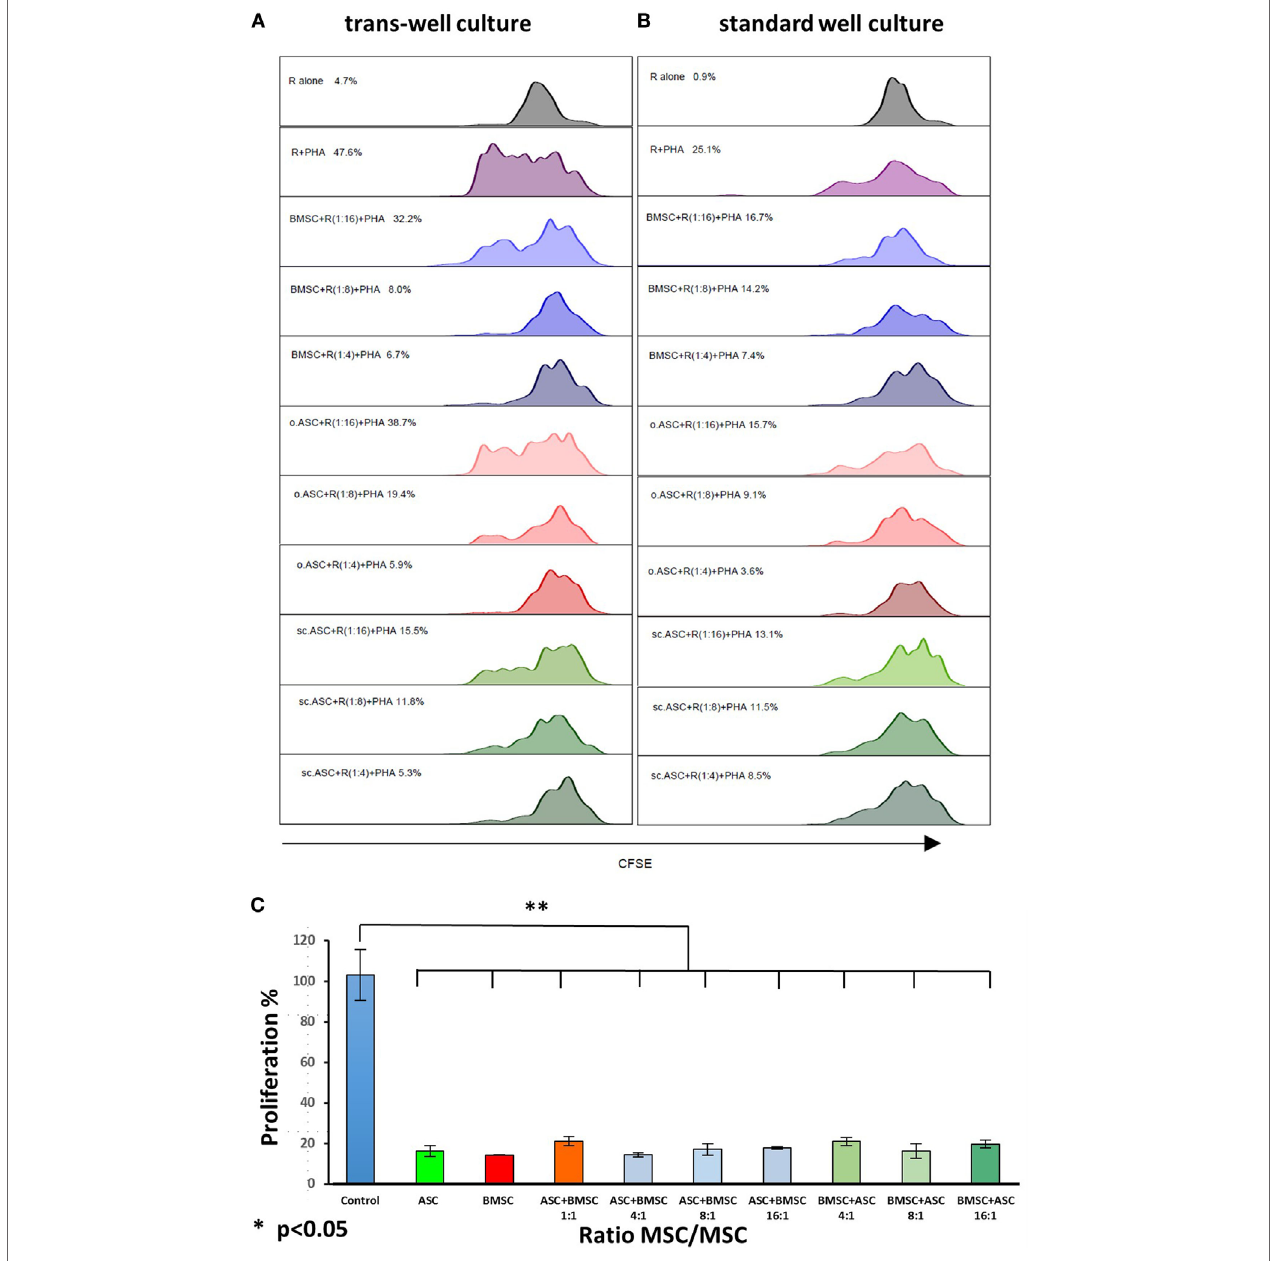
FigUre 7 | Head to head comparison between trans-well and standard well proliferation assay stimulated with phytohemagglutinin (PHA). Allogenic mesenchymal stem cell (MSC) deriving from the same donor were added in different ratios to carboxyfluorescein succinimidyl ester stained responder cells, resulting in a dose-dependent suppression of CD3 + , CD4 + cells. Absence of cell contact (a) did not result in a loss of suppression performance compared with standard co-culture (B) . When adipose-derived mesenchymal stem cells (ASCs) and bone marrow-derived mesenchymal stem cells (BMSCs) were mixed and added to co-cultures (c) at a constant ratio of 4:1 between responder peripheral blood mononuclear cells and the MSCs added, a synergistic effect of s.c.ASC and BMSC is demonstrated resulting in a significant suppression ( p < 0.01), independent on the composition of the mixed MSC (more ASC vs. more BMSC). Results for mixed MSCs showed no significant difference if compared with single-cell